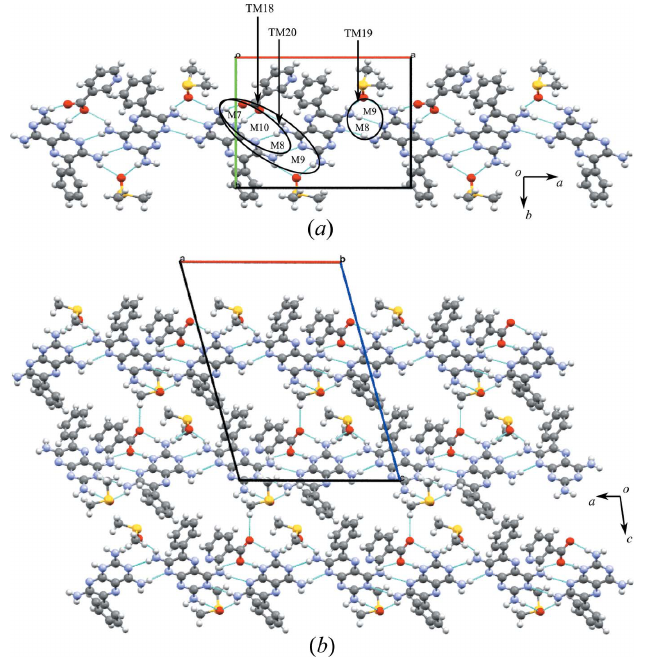
Figure 11 ( a ) The motifs M7, M10, M8 and M9 (TM18), M8 and M9 (TM19), and M7, M10 and M8 (TM20) that create the hydrogen-bonded tape and ( b ) sheet that forms part of the crystal structure of 1f (cid:3)